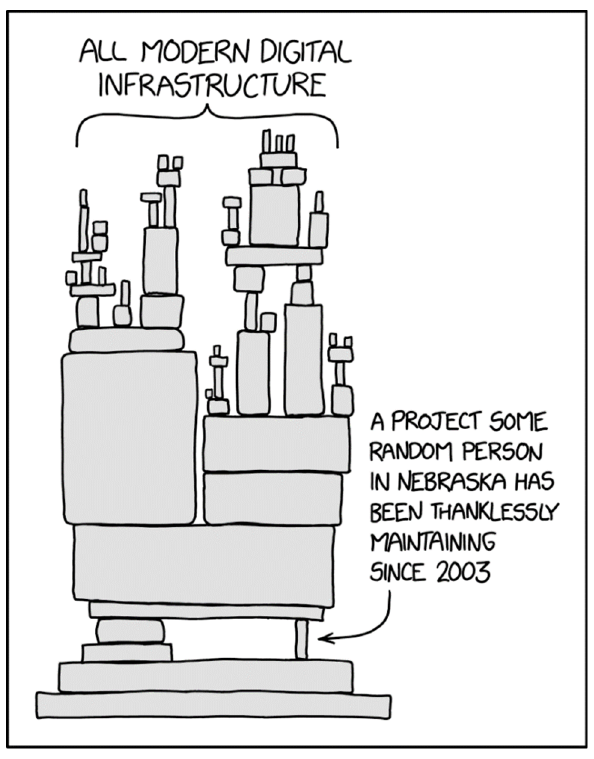
Figure 1. Dependency (Munroe,